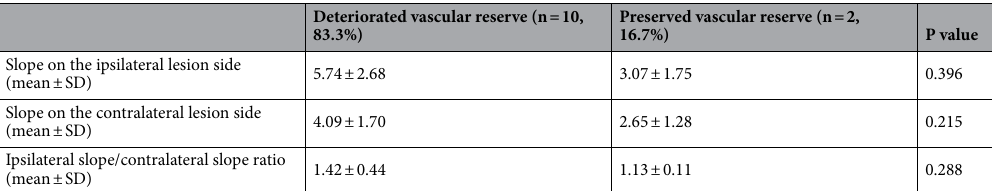
Table 3. The slope of oxyhemoglobin wave according to vascular reserve among the patients with acute ischemic stroke (n = 12). SD standard deviation. Unit = Fs·10–4 mM/sec; Fs = 8.138 Hz.